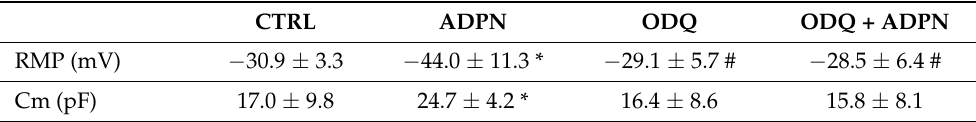
Table 1. Effects of different treatments on passive properties of gastric fundus smooth muscle cells (SMCs). CTRL ADPN ODQ ODQ + ADPN RMP (mV) − 30.9 ± 3.3 Cm